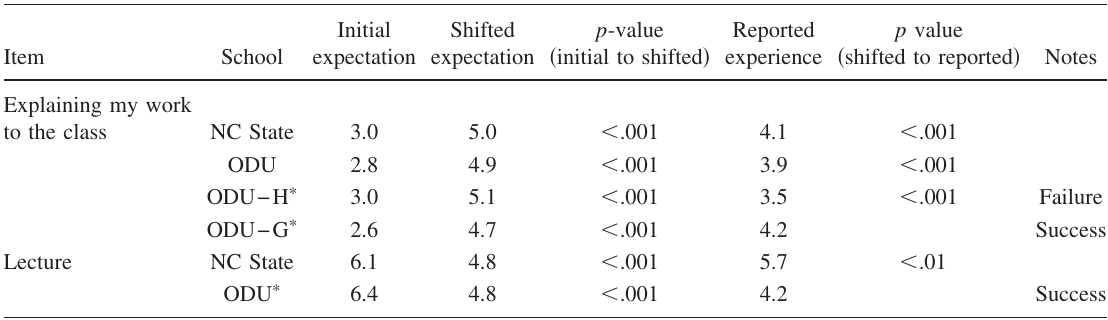
TABLE III. Sample items fitting an “overshooting” profile. Items marked with an asterisk are not over- shoots but are provided for comparison